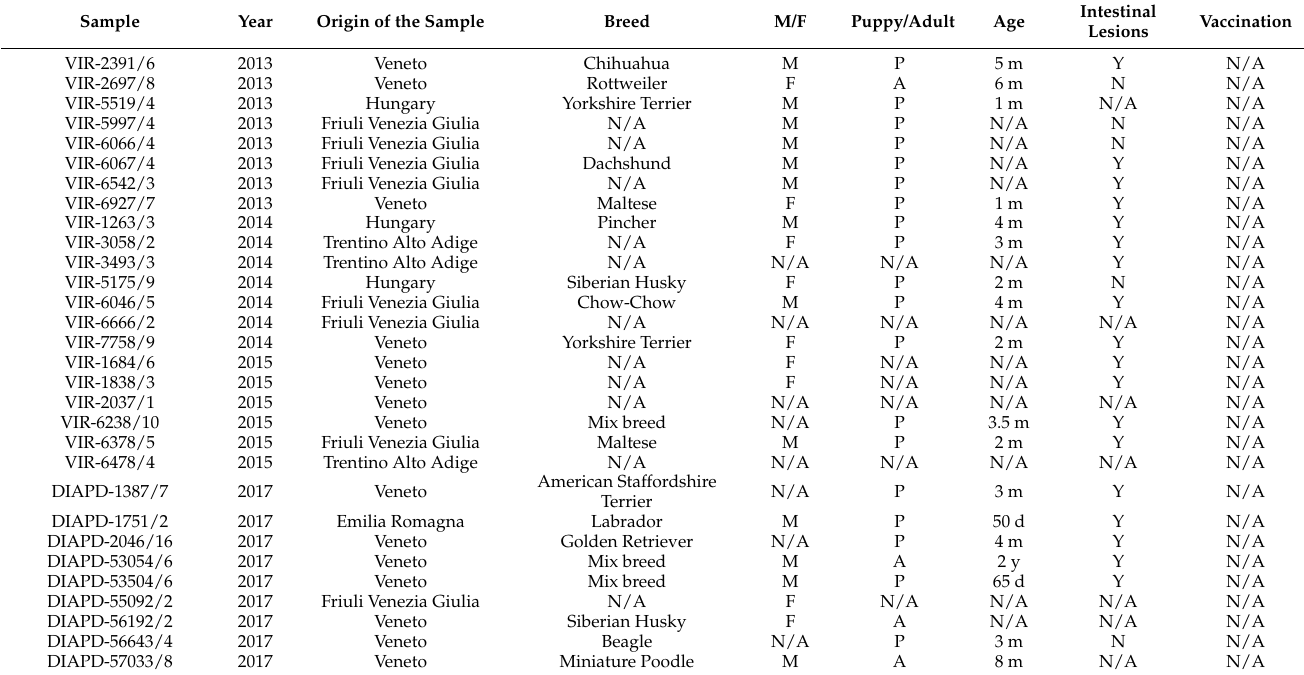
Table 1. Information of CPV-2-positive samples included in the present study. Year of isolation, Italian region of origin and information regarding dog samples are reported. M = male, F = female, P = puppy, A = adult, Y = yes, N = no, N/A= not available information, d = days, m = months, y = years.